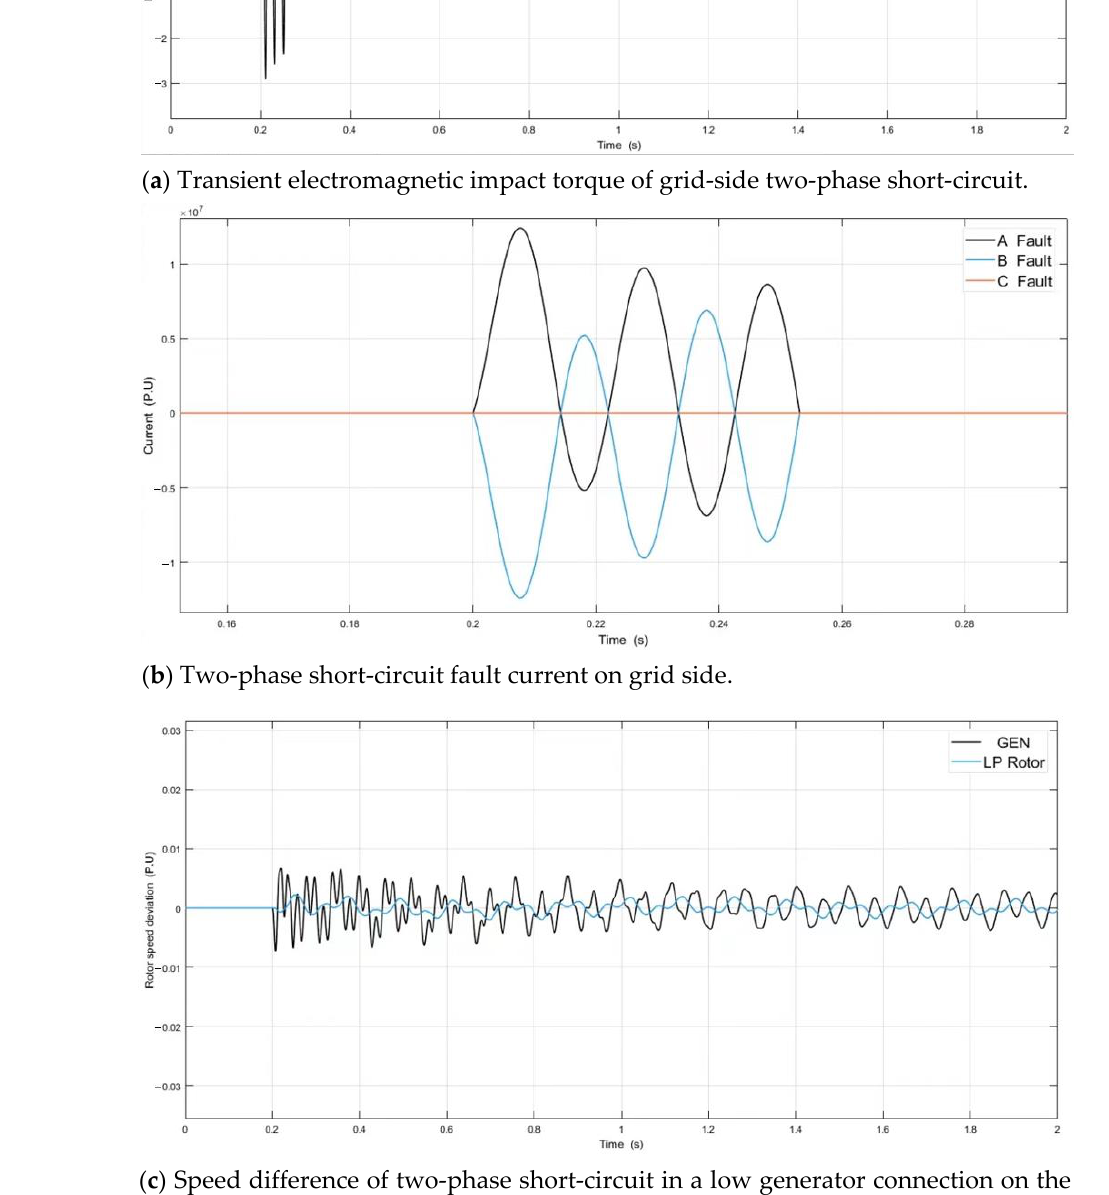
Figure 8. Characteristic curve of two-phase short circuit fault.